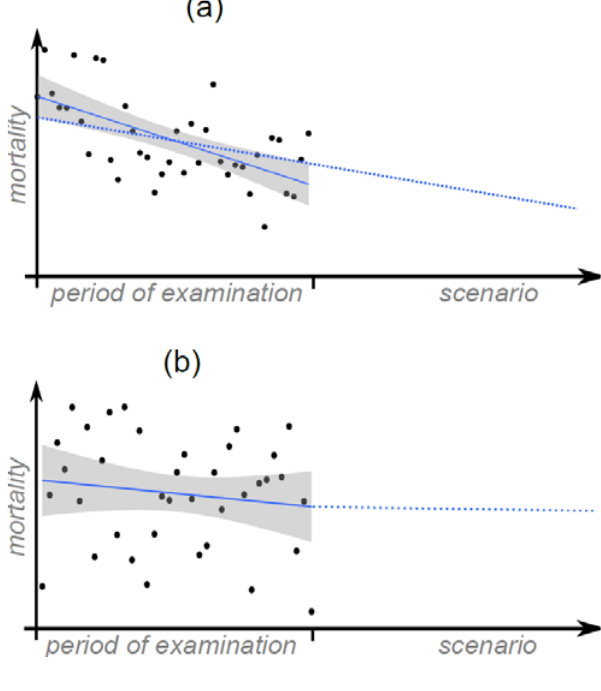
Figure 1. Diagram of the two approaches to assess the future development of sensitivity to thermal stress: Extrapolation of significant (a) and non significant (b) trends (scenario period in relation to the period of examination is not true to